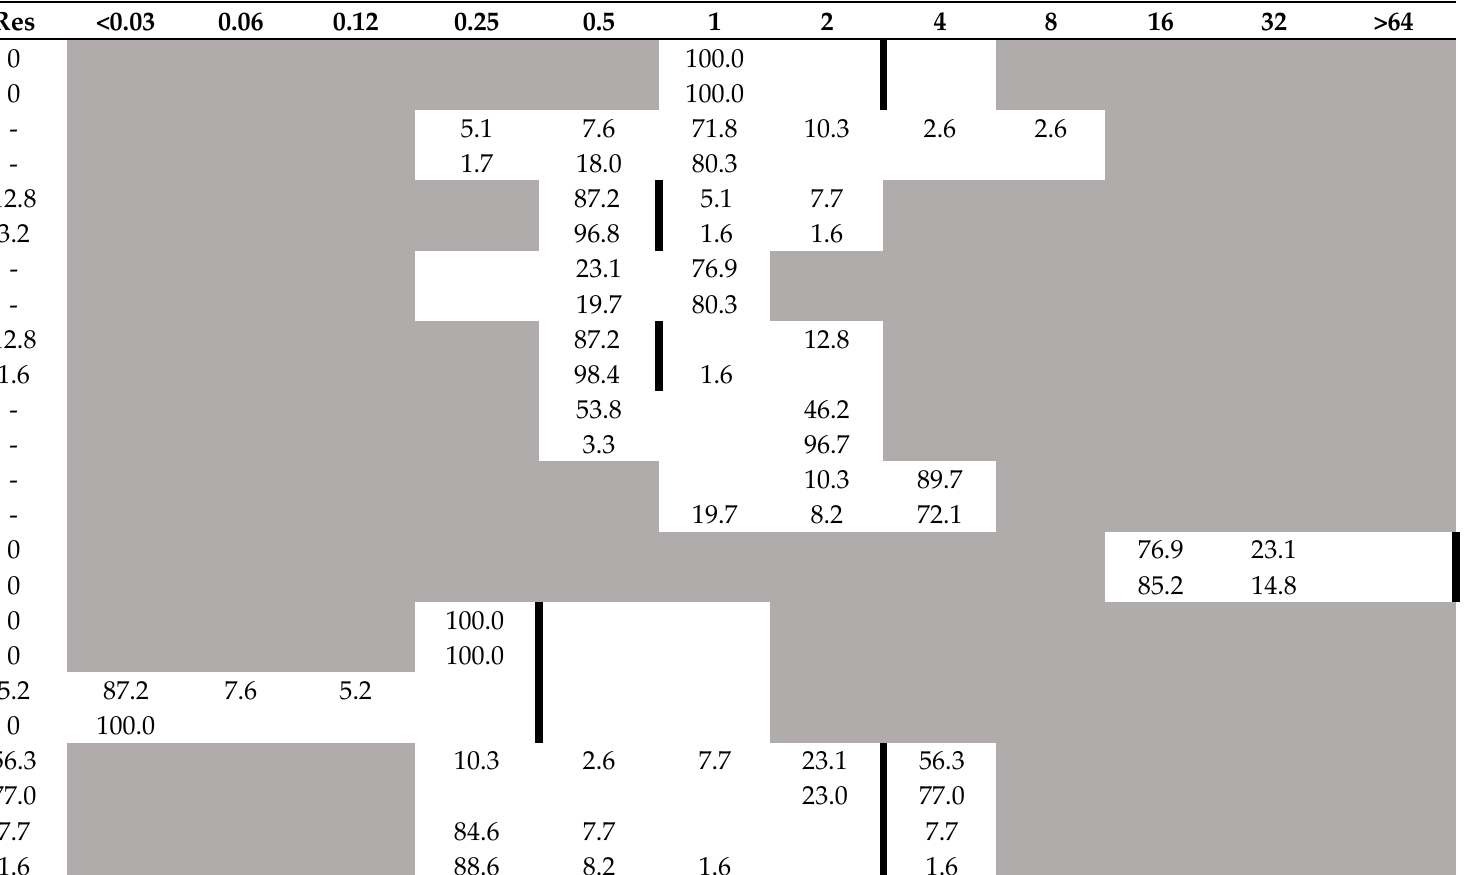
Table 3. Distribution of MICs (mg/L) and resistance of the 100 isolates of Streptococcus spp. from the cranial vagina of inseminated (I) and non-inseminated (NI) mares. The results are shown as the percentage of isolates at different MIC values. Streptococcus spp. from inseminated mares (n = 10), Streptococcus equi subsp. zooepidemicus from inseminated mares (n = 21) and non-inseminated mares (n = 13), and Streptococcus equisimilis from inseminated mares (n = 8) and non-inseminated mares (n = 48).